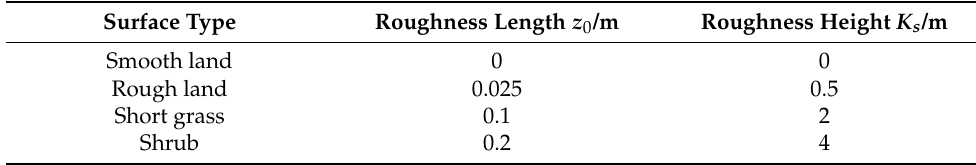
Table 1. Roughness of different surface conditions.